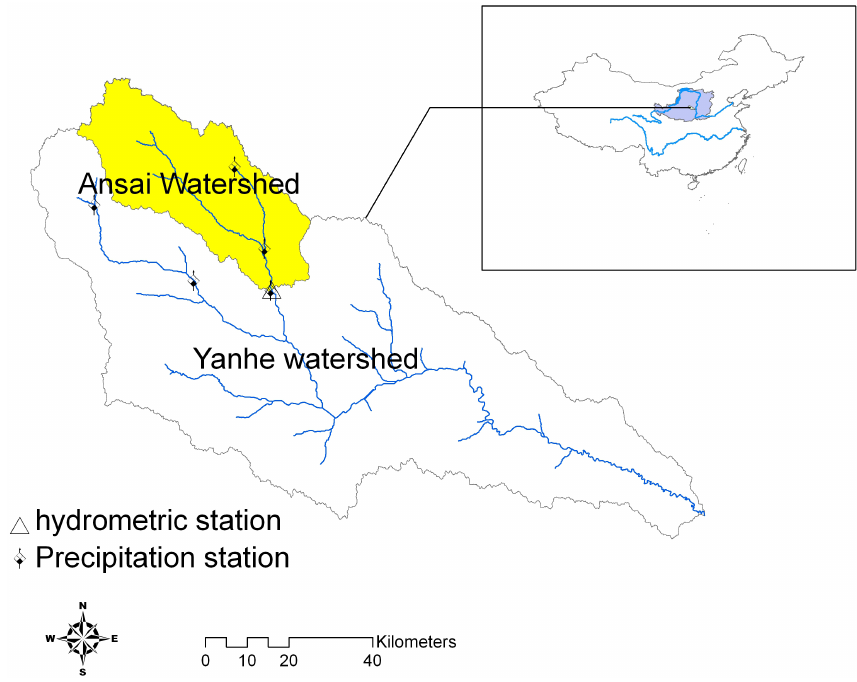
Fig. 1. Study area and the distribution of hydrometric station and precipitation